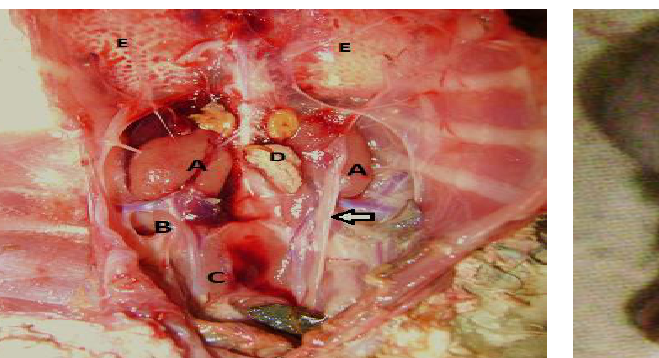
Figure, 2: Left and right kidneys after removal from cadavers shows: (A) Cranial lobe, (B) Midl lobe, (C) Caudal lobe, (Arrow shows